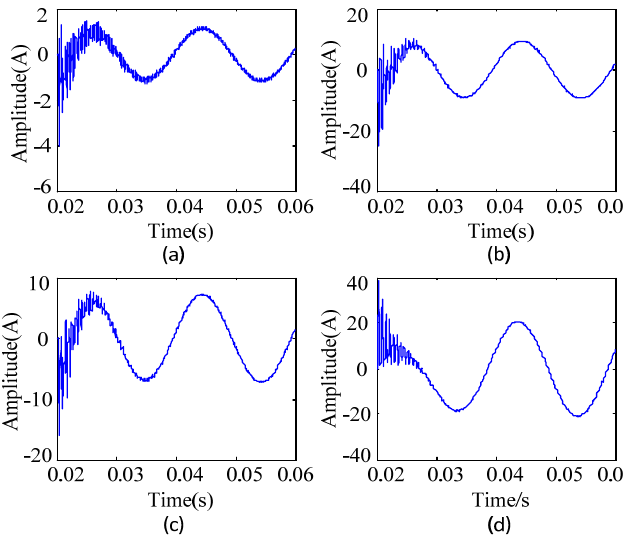
Figure 12. TZSCs for SPG fault (Case 2). ( a ) Lian L 1 ; ( b ) Lian L 2 ; ( c ) Lian L 3 ; ( d ) Lian L 4 .